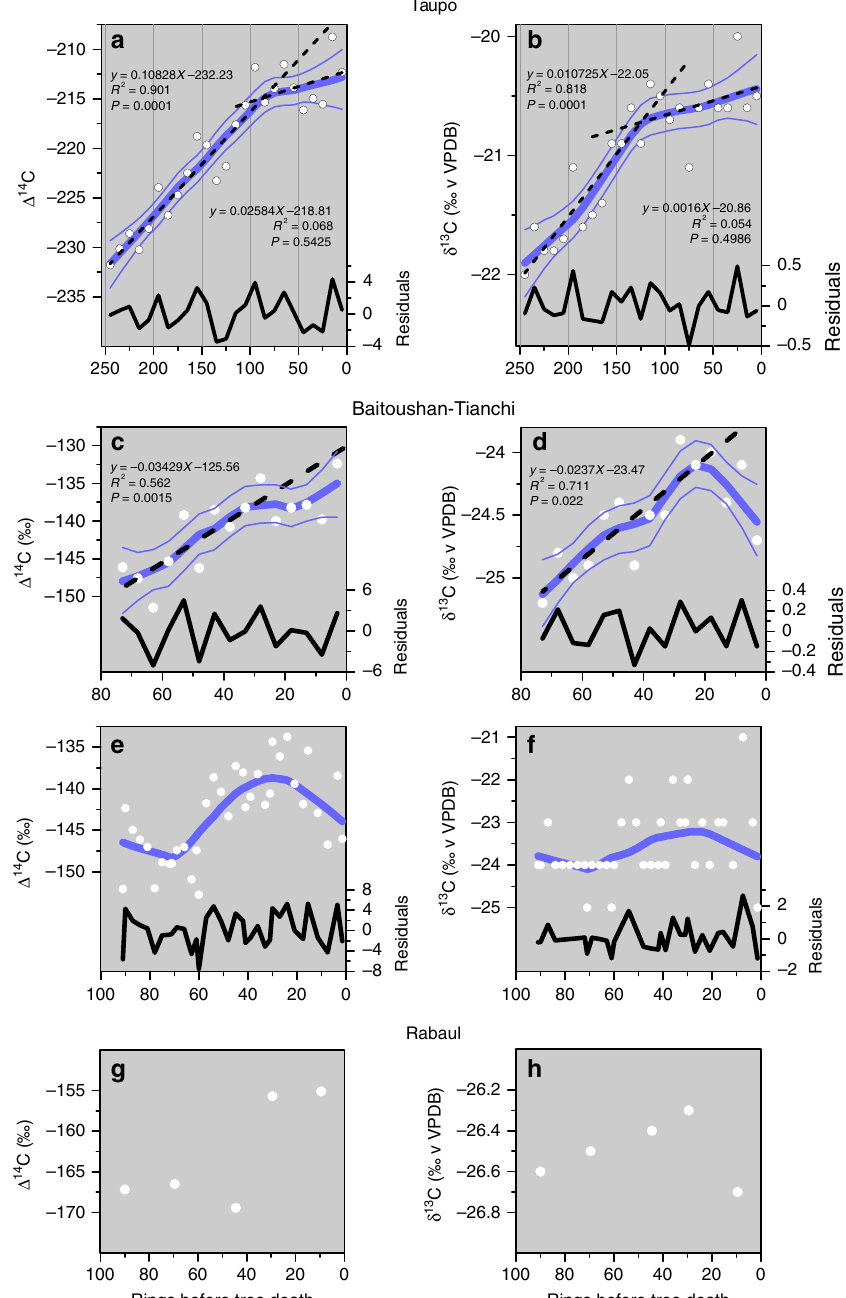
Fig. 3 Patterns of variation in carbon isotopic ratios ( Δ 14 C, δ 13 C) in trees close to the Taupo, Baitoushan-Tianchi, and Rabaul volcanoes before major eruptions. Carbon isotope ratios plateaued or declined as the eruptions approached. a , b Taupo ignimbrite (data, ref. 7 ): thick blue line, 0.5 LOESS fi t; thin blue lines, 2.5 and 97.5 percentiles of LOESS; broken black lines, linear fi ts before and after break in LOESS curve; solid black line residuals of LOESS fi t. c , d Baitoushan-Tianchi (data, ref. 26 ): details as in a and b . e , f Baitoushan-Tianchi (data, ref. 25 ; δ 13 C reported as integers); lines as in a and b , without linear fi ts. g , h Rabaul (data, ref. 27 ): values only; insuf fi cient data for LOESS fi